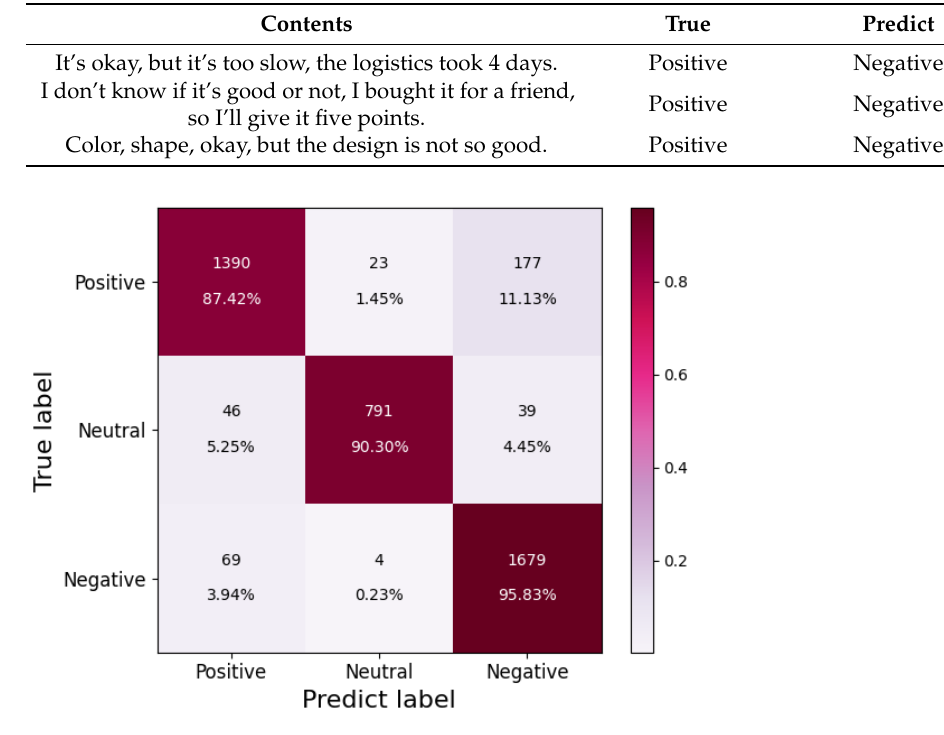
Table 9. Examples of mispredictions .